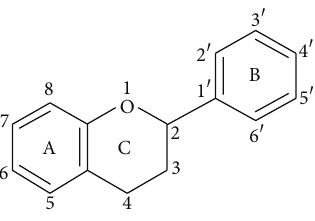
Figure 1: Basic flavonoid